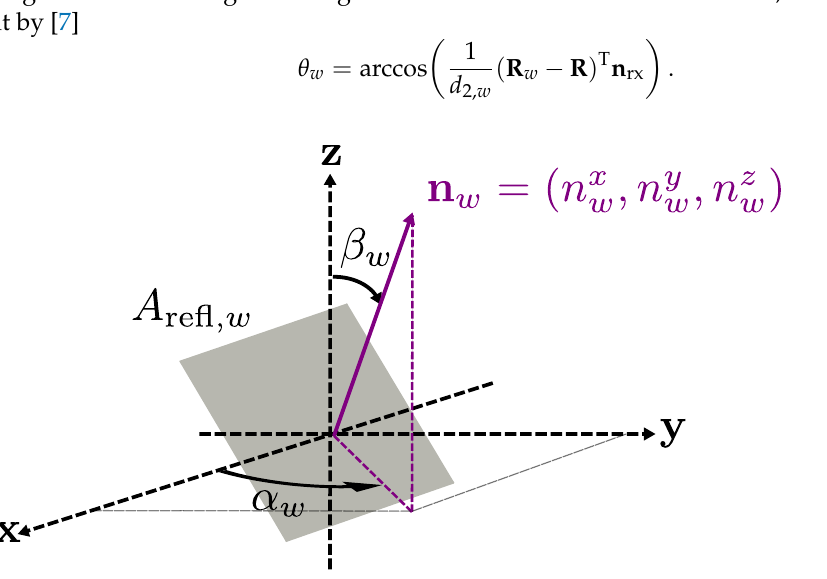
Figure 2. Tilt and rotation angles for the w th